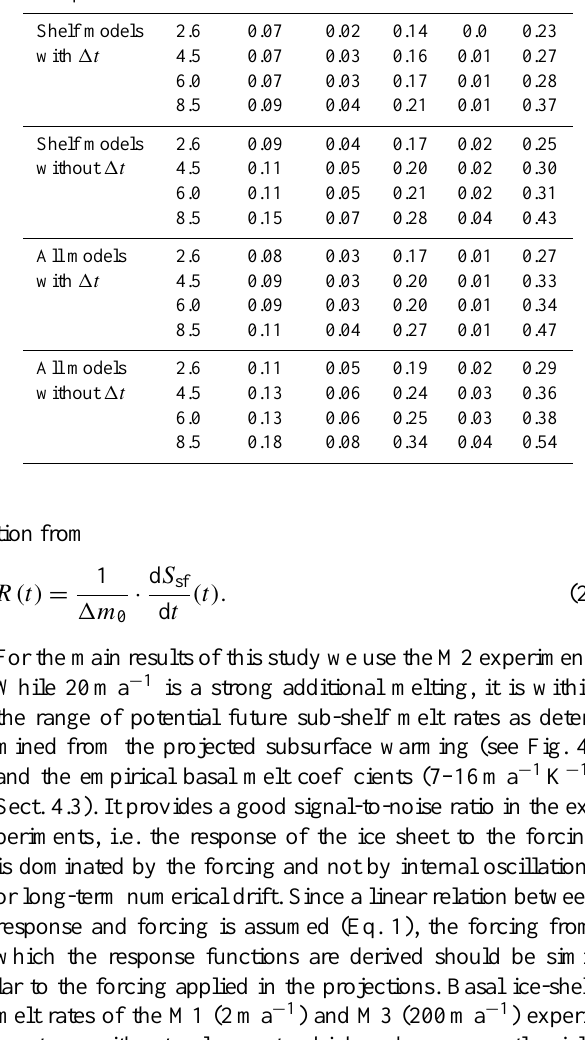
Table 4. Ross Sea sector: scaling coefficients and time delay 1t between increases in global mean temperature and subsurface ocean temperature anomalies. Model ACCESS1-0